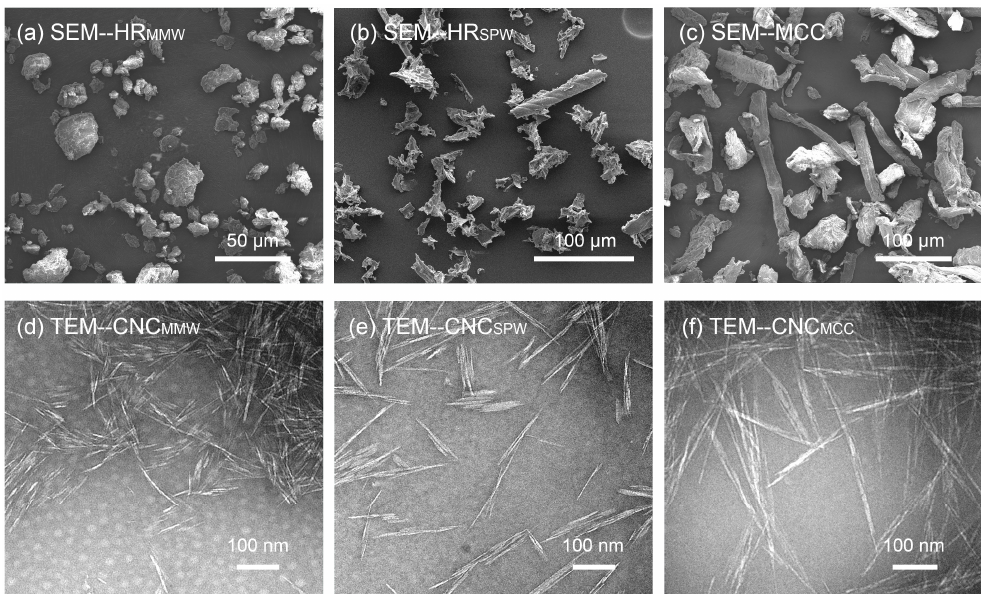
Figure 2. Scanning electron microscope (SEM) and transmittance electron microscope (TEM) images of HR MMW , HR SPW , MCC, and their CNCs. ( a ) hydrolyzed residues from midium milled wood, HR MMW ; ( b ) hydrolyzed residues from sulfite pretreated wood, HR SPW ; ( c ) microcrystalline cellulose, MCC; ( d ) cellulose nanocrystals from HR MMW , CNC MMW ; ( e ) cellulose nanocrystals from HR SPW , CNC SPW ; TEM images Table 2. Particle size of HR MMW , HR SPW , MCC, and their